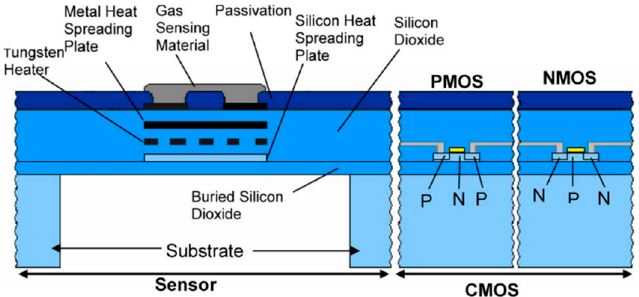
Figure 11. Monolithic gas sensor fabricated with silicon on insulator (SOI) CMOS technology (from [50]).